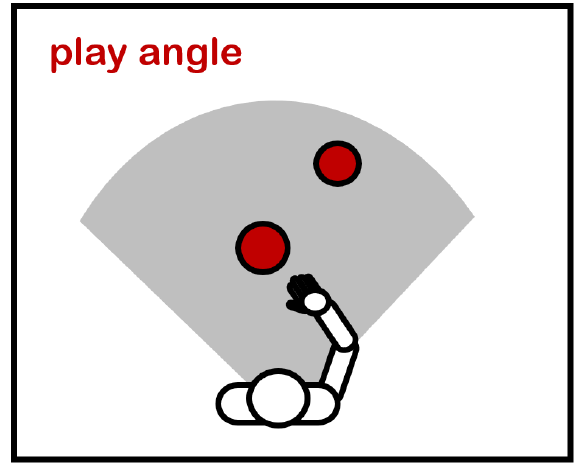
Figure 7. The play angle.